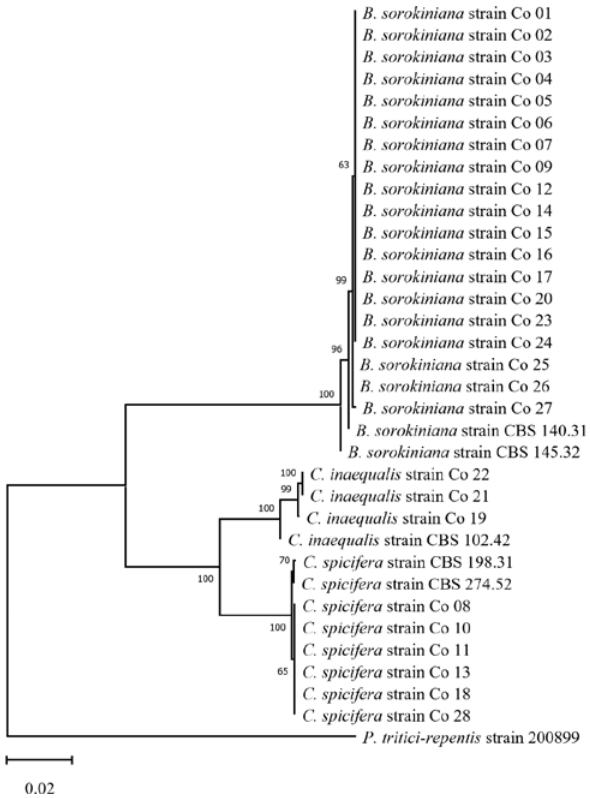
Figure 1. The neighbour-joining tree generated using Tamura and Nei (1993) for analyses of combined datasets of the ITS and GPDH sequences of 28 isolates from the present study, and for reference isolates. The phylogenetic tree was rooted with the Pyrenophora tritici - repentis reference strain. The percentage of replicate trees in which the associated taxa clustered together in the bootstrap test (1,000 replicates) are shown next to each